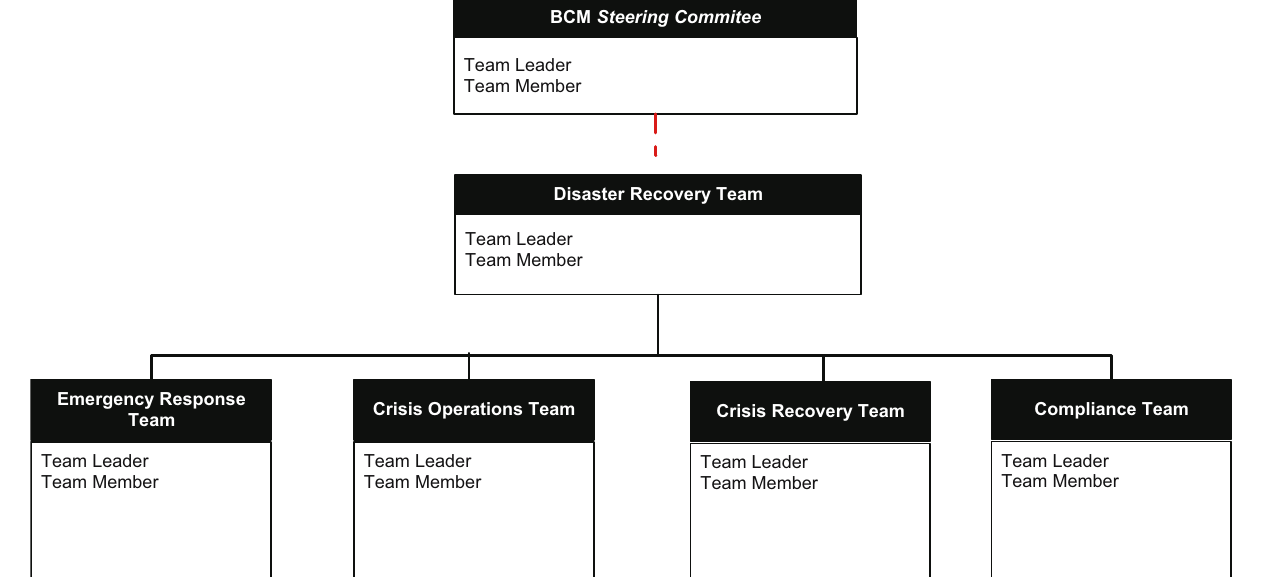
Figure 1: Organizational Structure of